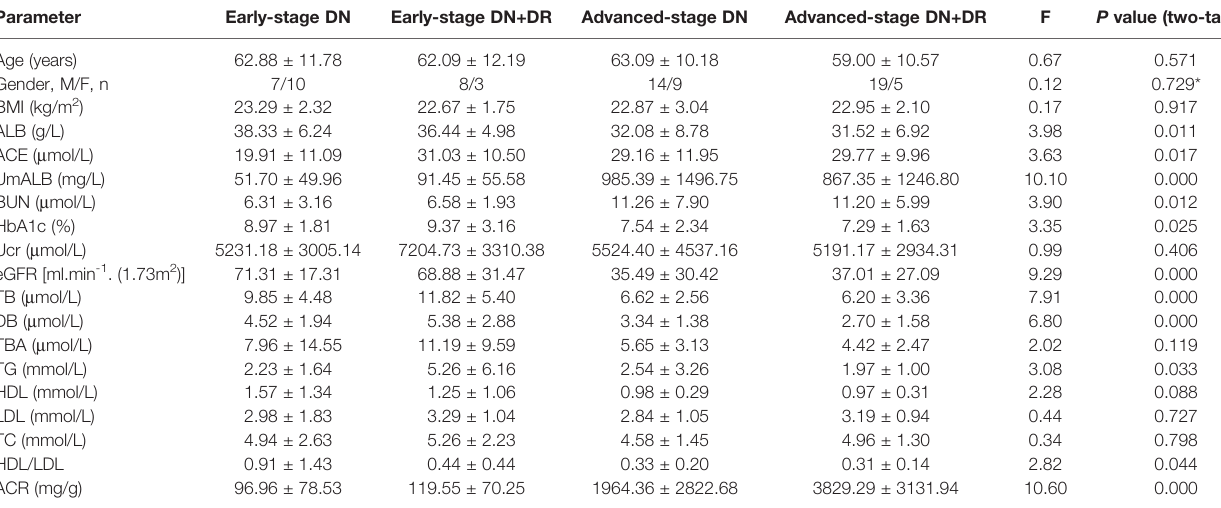
TABLE 4 | Characteristics of different DN subgroup patients (mean ±